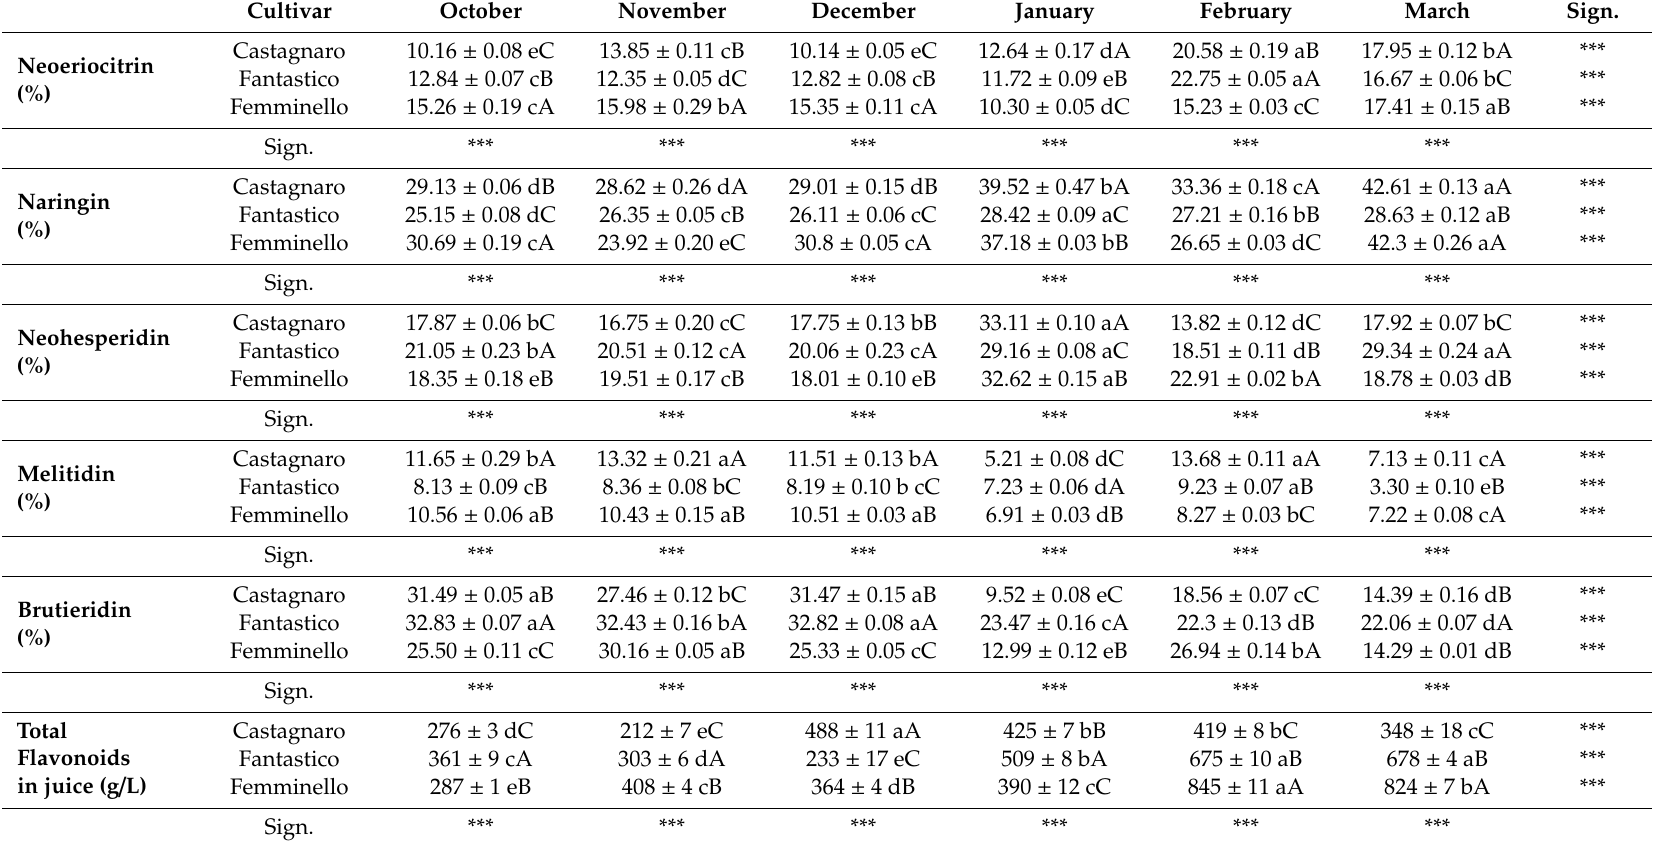
Table 6. Main flavonoids in bergamot juice. Results are presented as the mean value ± standard deviation, n = 8, (2016–2017 and 2017–2018 harvest years). *** significance at p < 0.001; ** significance at p < 0.01; * significance at p < 0.05. Means in the same line are distinguished by small letters. Means in the same column are distinguished by capital